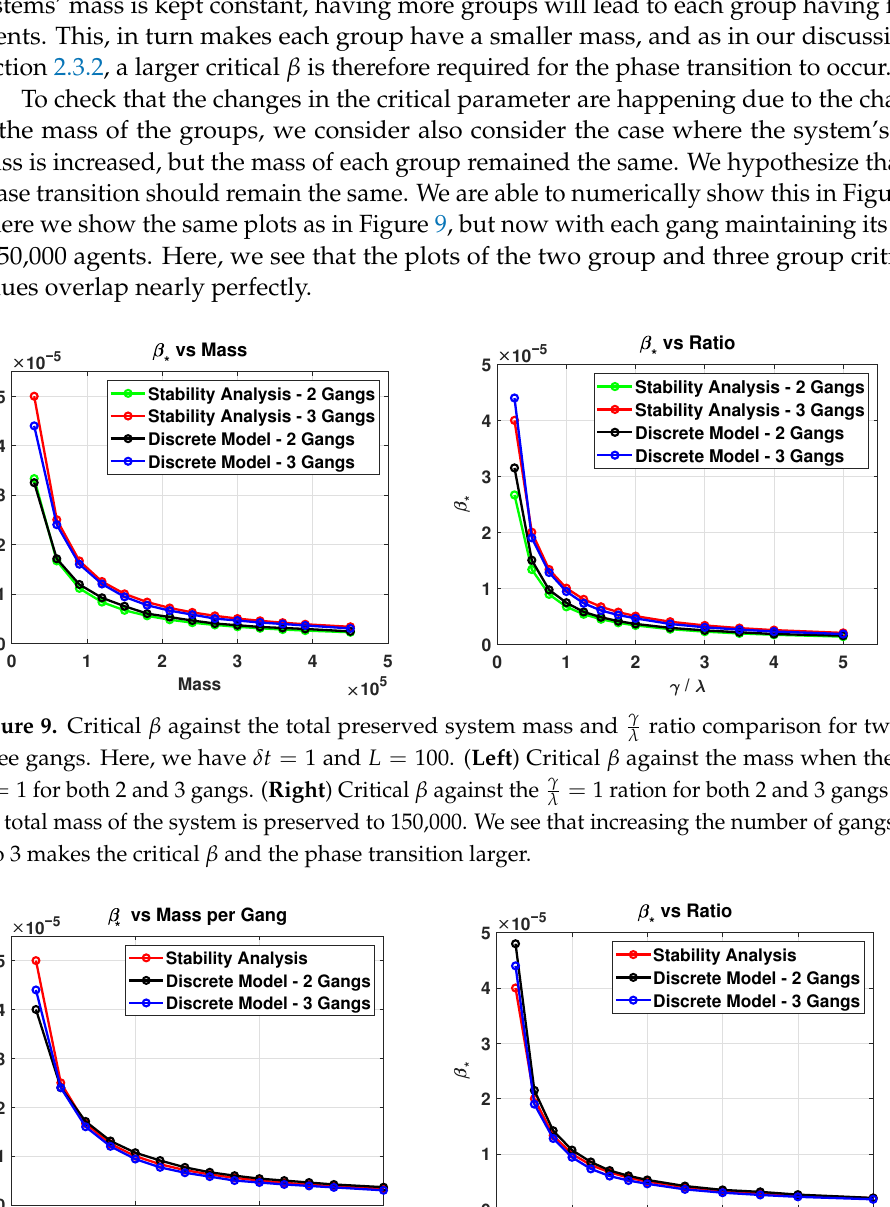
Figure 10. Critical β against the mass and γ ratio comparison for two and three gangs. Here, we λ = 1 for have δ t = 1 and L = 100. ( Left ) Critical β against the mass of each gang when the ratio γ λ = 1 ratio for both 2 and 3 gangs when the mass both 2 and 3 gangs. ( Right ) Critical β against the γ λ of each is 50,000. We see that increasing the number of gangs from 2 to 3 does not affect the phase transition of the system, and that the critical β is similar when the number of gangs is